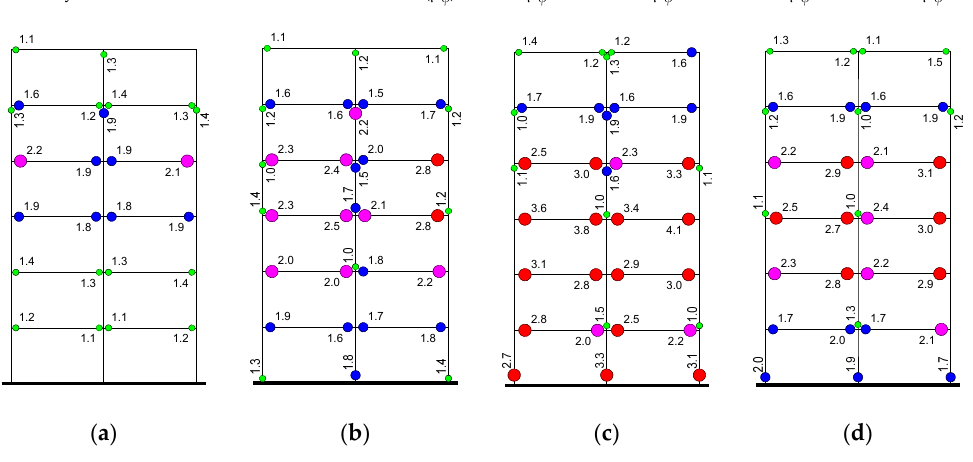
Figure 19. Plastic hinges of the single-frame at Axis 1: ( a ) M1; ( b ) M2; ( c ) M3; ( d ) M6. The hinge rates of the beams and columns continue to increase with increasing seismic intensity. The average hinge rates for the model beams and columns at different levels under 0.4 g and 0.62 g seismic action are shown in Figures 20–22. For structure models M1, M2, M3 and M6 with different geometric arrangements, as γ intra increases, the average hinge rate along the slope direction of the column decreases significantly, and the rate of µ φ in the range of [3.0, + ∞ ) decreases. However, for structure models M3, M4, and M5 with the same geometric arrangement, the average hinge rate along the slope direction of the column gradually increases with the increasing γ intra , and the rate of µ φ reaches [3.0, + ∞ ) increases, which is consistent with the opposite distribution pattern of the plastic hinge as depicted above. The distribution of hinge rate across the slope direction of the column has a noticeable change with increasing seismic intensity. The relationship between the distribution of column hinge rate across the slope direction and the variation of γ intra and e / r is not apparent when the seismic intensity is 0.4 g. Under the earthquake intensity of 0.62 g, the variation law of the column hinge rate across the slope direction is similar to that along the slope direction, but the rate of µ φ reaching [3.0, + ∞ ] is smaller than that along the slope direction. For beams, the average hinge rate tends to decrease and then increase with increasing γ intra under the earthquake action of 0.4 g. As the seismic intensity increases to 0.62 g, the pattern of the average hinge rate at the beam end changes, increasing and then decreasing with the increasing γ intra , but the rate of µ φ reaching [3.0, + ∞ ) is closer.